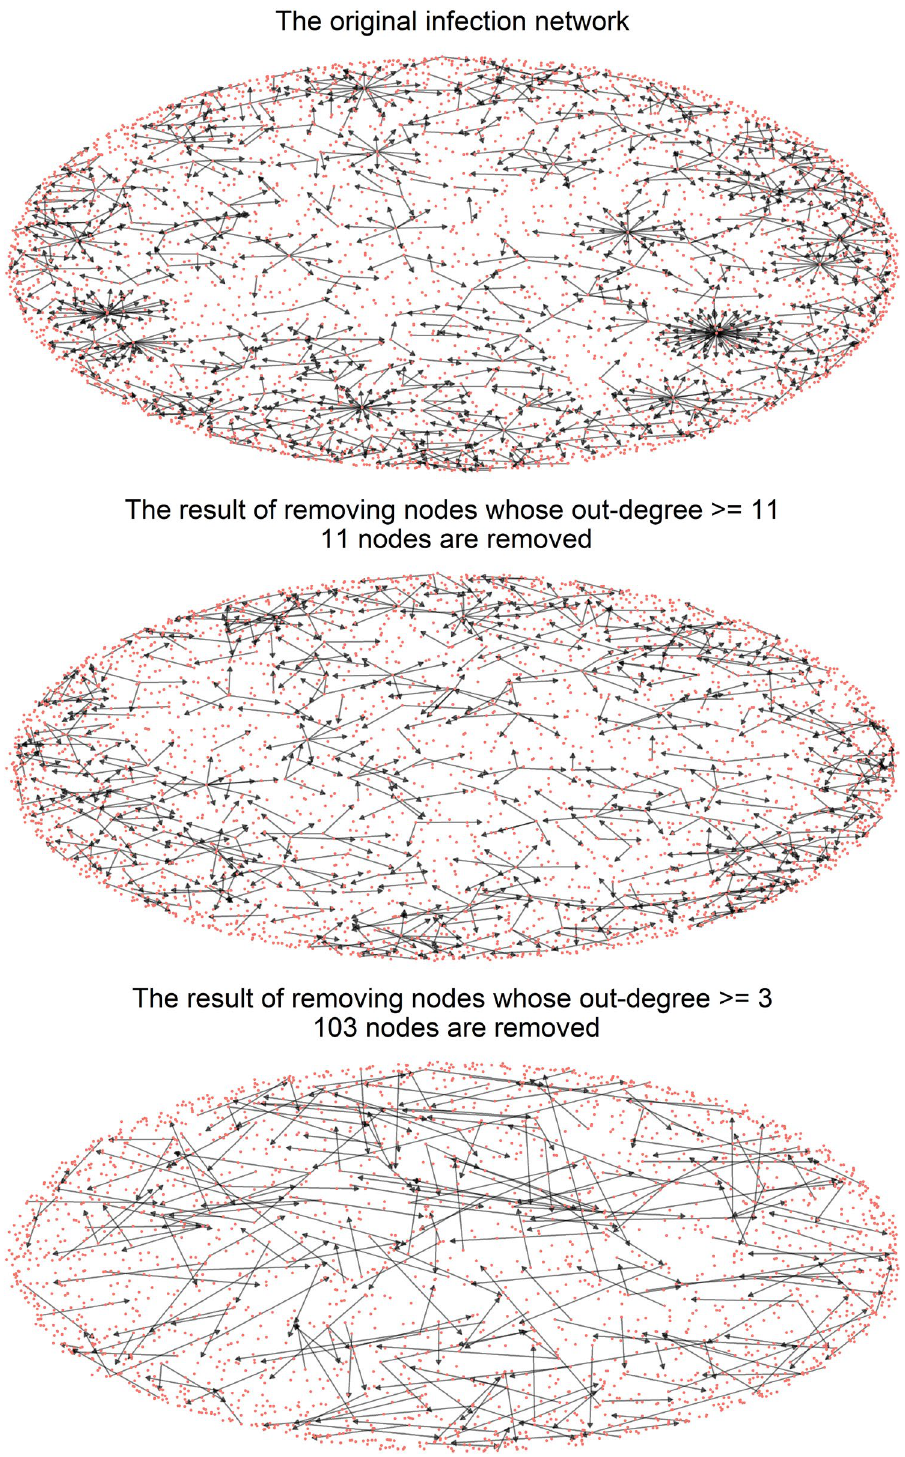
Figure 7. The change in the network’s shape as top nodes in the out-degree are